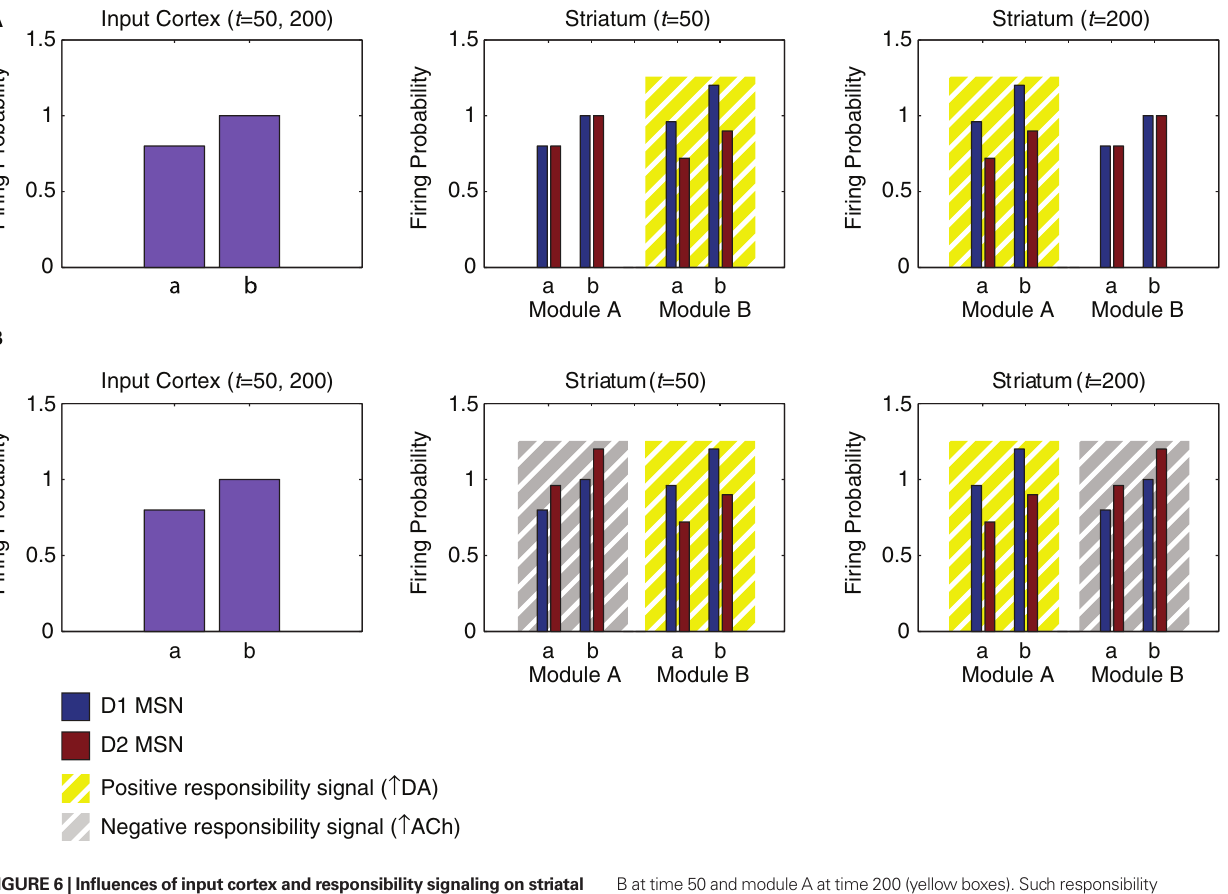
Figure 6 | influences of input cortex and responsibility signaling on striatal matrix MSN activity in the network model. We model two neurons of the input region of the cortex, each representing information related to the value of action “a” or “b.” These neurons project, respectively, to a D1 and a D2 matrix MSN in each of two modules in the striatum. (A) Cortical and striatal activity (arbitrary units) for simulation using only positive responsibility signals. The effect of positive responsibility signals is labeled “ ↑ DA,” based on the possibility that they may involve an increase in phasic local striatal dopamine release (triggered by a decrease in local acetylcholine release). Responsibility is assigned to module